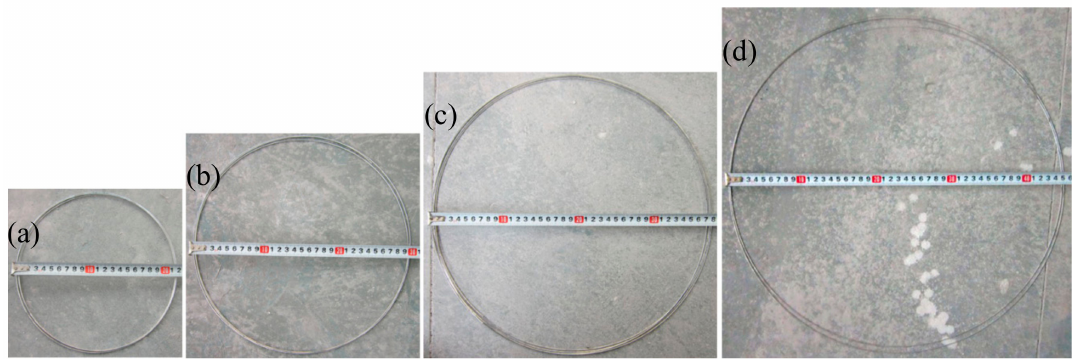
Figure 16. Measured values of cast during adjusting process: ( a ) cast = 215 mm; ( b ) cast = 295 mm; ( c ) cast = 375 mm; ( d ) cast = 450